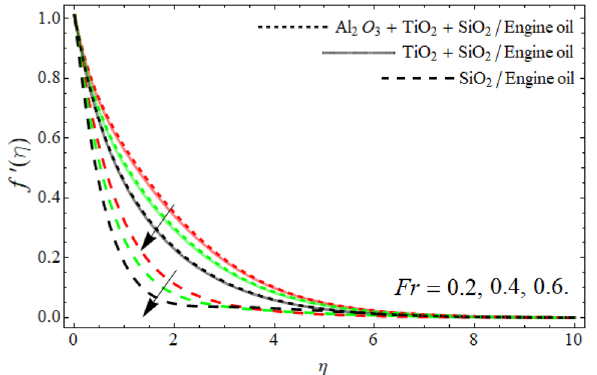
Figure 6. Velocity f ′ (η) field versus Fr .